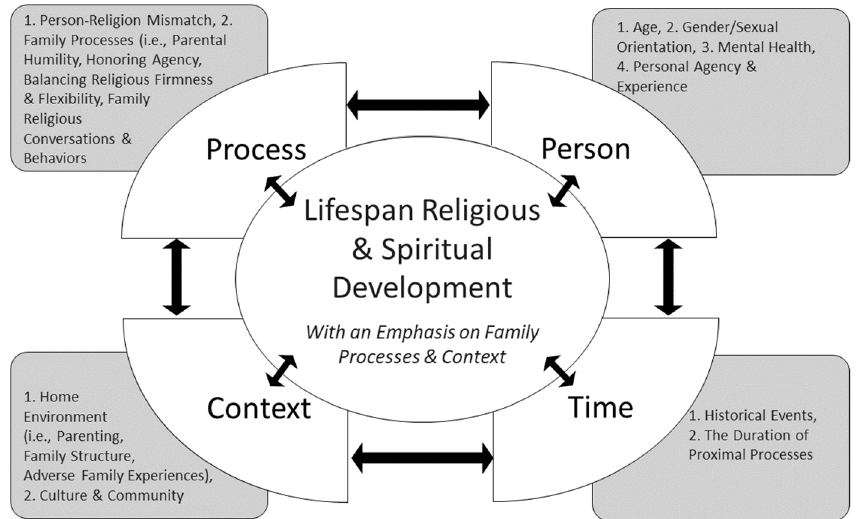
Figure 1. Person-Process-Context-Time framework of lifespan religious and spiritual development with an emphasis on family process and context.